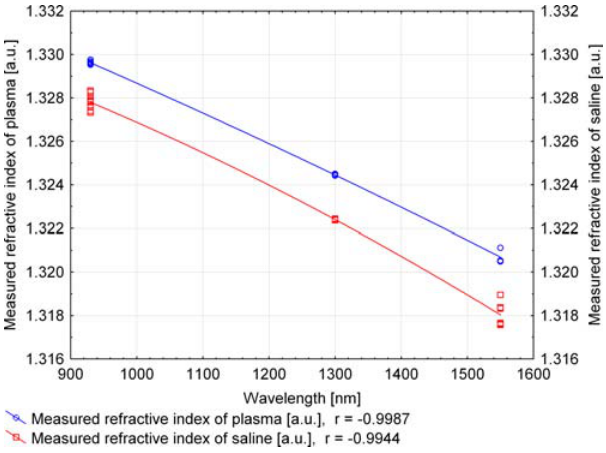
Fig. 6. Dispersion characteristics of saline and